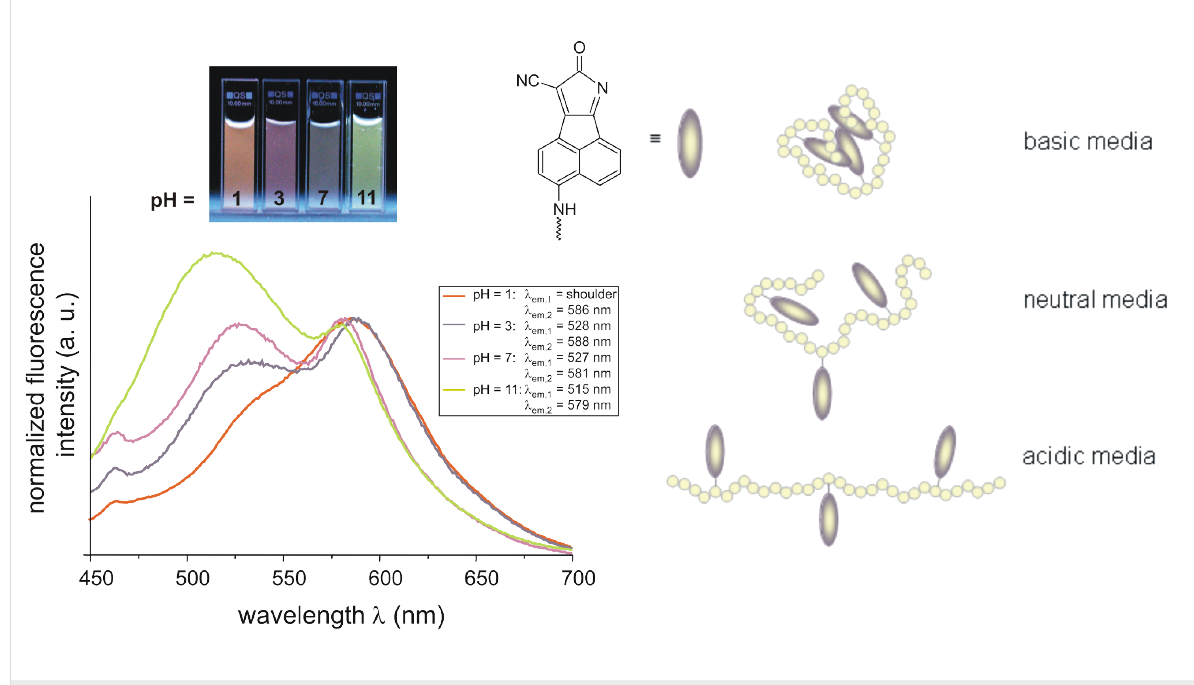
Figure 6: Normalized emission spectra of 1-P in water at four different pH values and a sketch of the assumed chain conformations of PVAm.